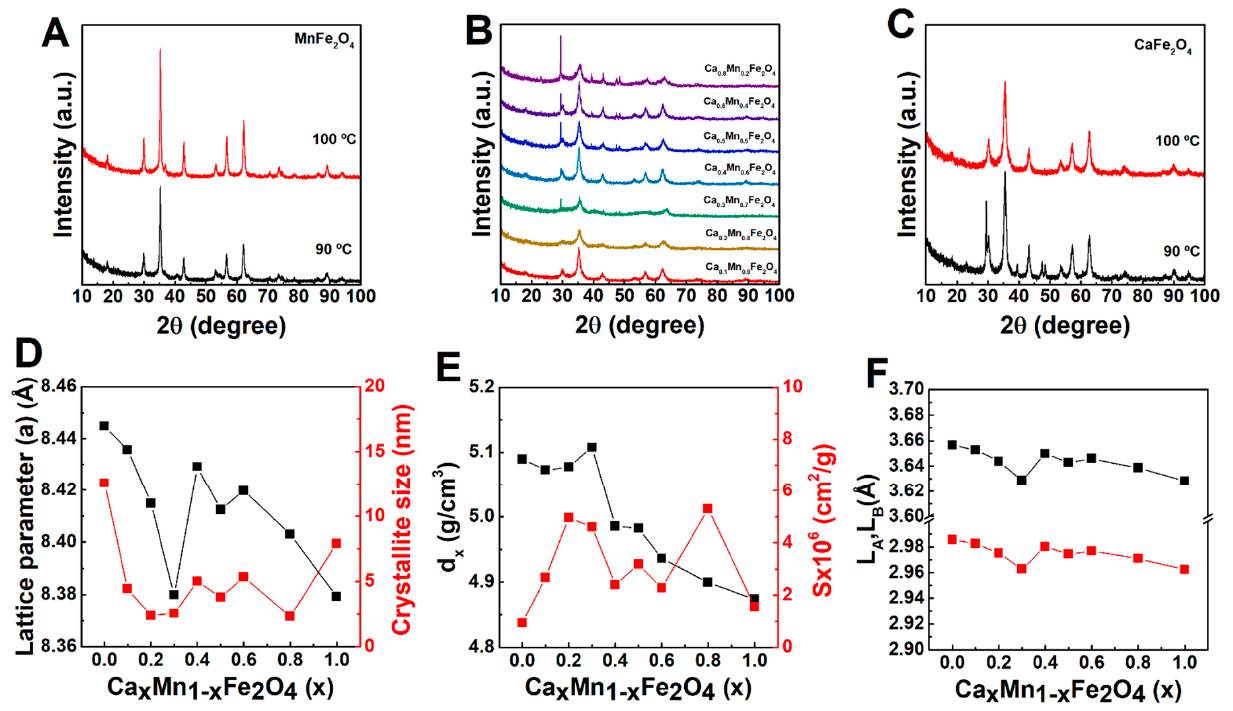
Figure 3. XRD patterns of ( A ) manganese ferrites, ( B ) calcium and manganese mixed ferrites, and ( C ) calcium ferrites. Dependence of ( D ) lattice parameter, crystallite size, ( E ) X-ray density (d x ), specific surface area (S), and ( F ) hopping length in tetragonal (L A ) and octahedral (L B ) sites on the Ca 2+ and Mn 2+ content.